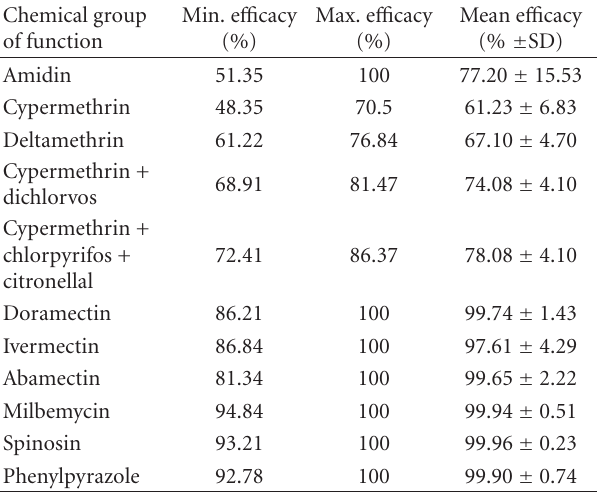
Table 1: E ffi cacy of di ff erent acaricide bases on populations of Rhipicephalus microplus collected from dairy herds in the state of Rondˆonia, Brazil.